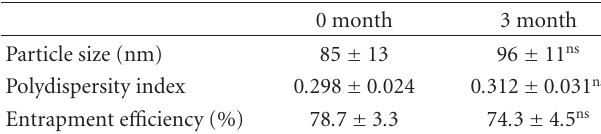
Table 2: The stability of tacrolimus-loaded ethosomes under storage condition (4 ◦ C).